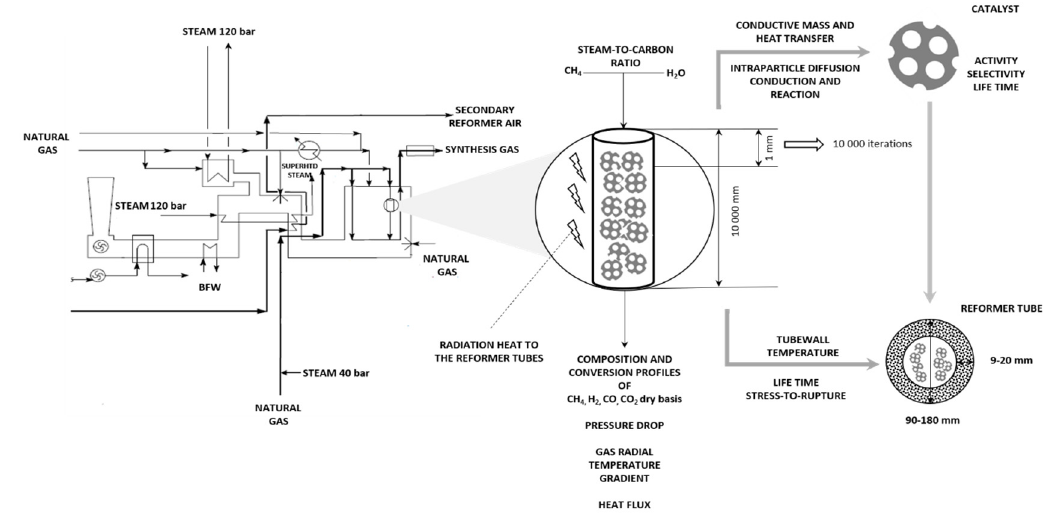
Figure 2. The schematic diagram of the top-fired SMR based on Kellogg Inc. design used in the model.